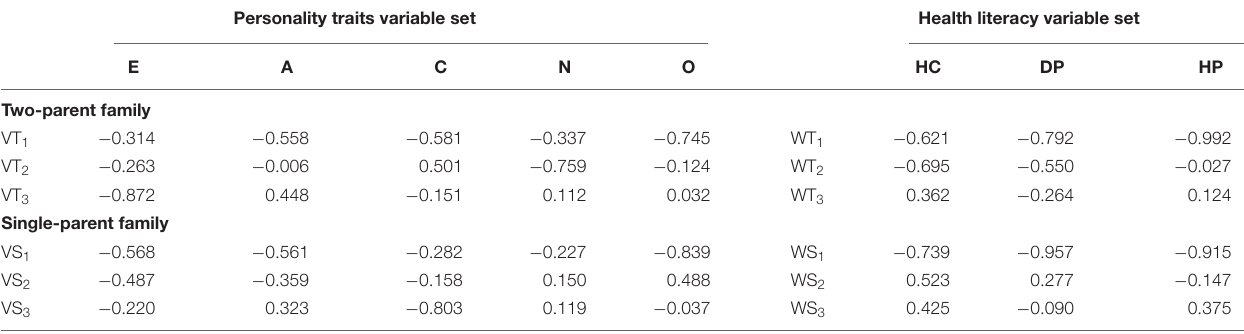
TABLE 7 | Canonical loadings for personality traits and health literacy in two types of family structure. Personality traits variable set Health literacy variable set